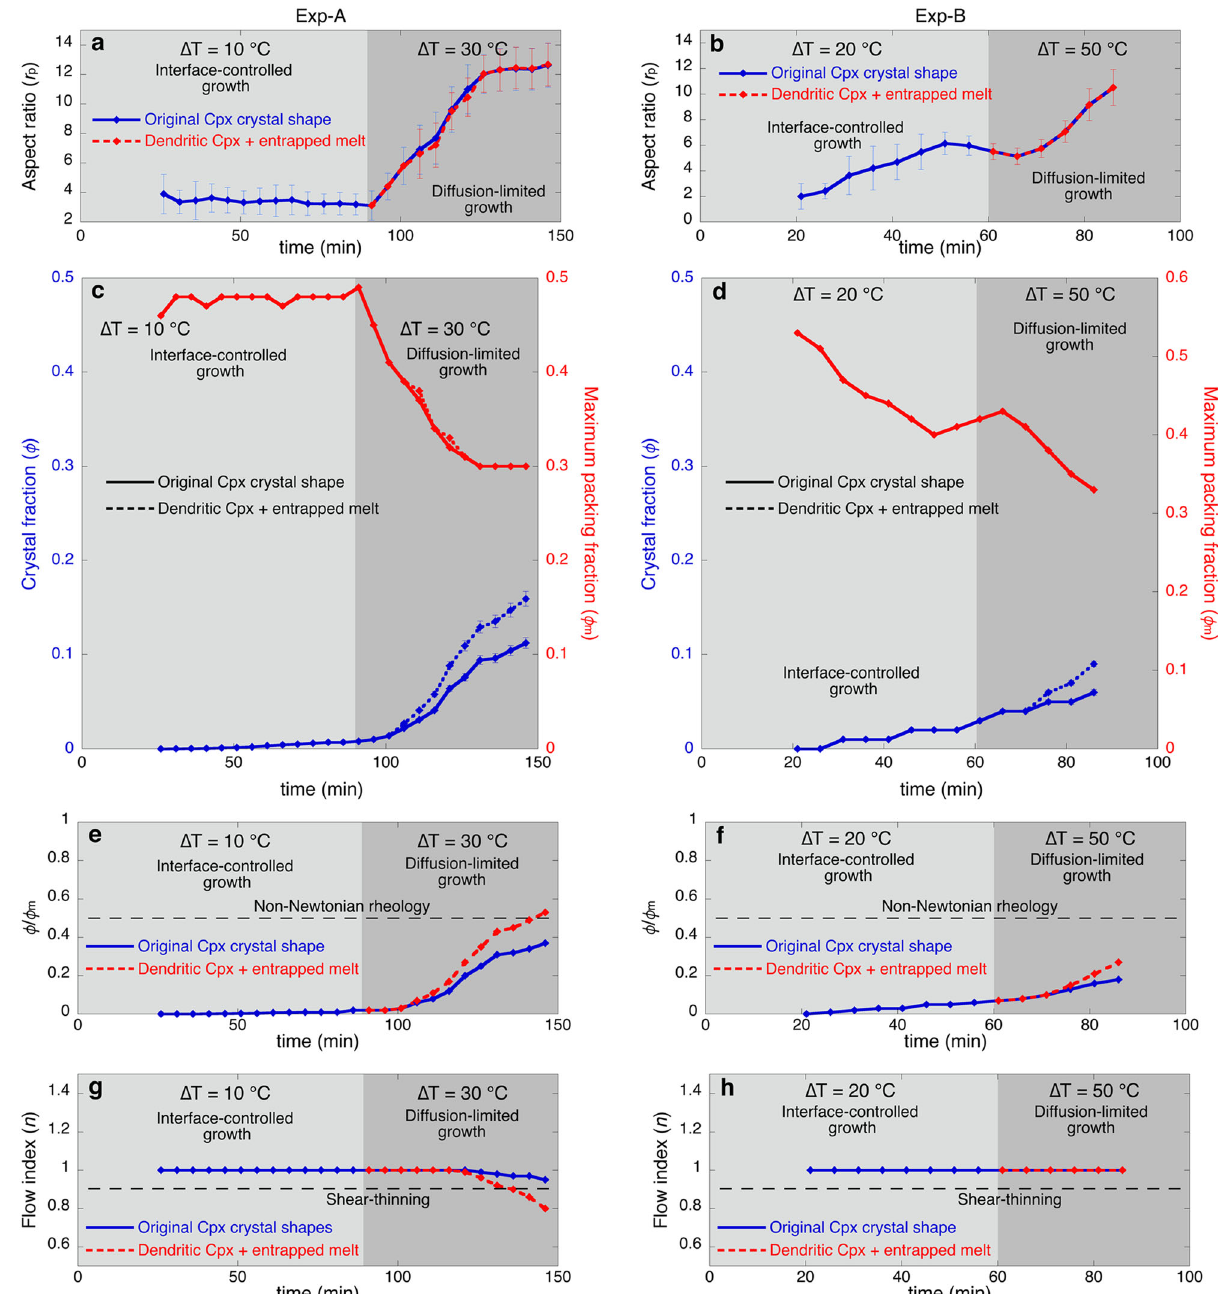
Fig. 5 Rheological transition of a trachybasaltic magma during crystallisation. a , b Evolution of clinopyroxene aspect ratio ( r p ) through time as a function of Δ T (undercooling) during the experiments Exp-A ( a ) and Exp-B ( b ). c , d Evolution of clinopyroxene crystal fraction ( ϕ ) through time as a function of Δ T during the experiments Exp-A ( c ) and Exp-B ( d ). Diffusion-limited growth, promoted at Δ T = 30 °C (Exp-A) and Δ T = 50 °C (Exp-B), favours dendritic crystal shapes which entrap melt within crystal branches. The entrapped melt within the original dendritic crystals (blue) is considered an additional solid part, which contributes to further increase the crystal volume of the dendritic crystals (red), increasing consequently the crystal volume fraction ( a , b ). c – h Evolution of the maximum packing fraction ( ϕ m ), ratio ϕ / ϕ m and fl ow index ( n ) which are indicators of the rheological behaviour of a crystal-bearing magma (Mader et al.). e , f Newtonian rheology is promoted at relatively low ϕ / ϕ m (<0.5), whereas non-Newtonian rheology, characterised for example by shear thinning, is more pronounced as ϕ / ϕ m increases. Shear thinning behaviour is promoted when n <1. a , c , e , g Light grey shading represents Δ T = 10 °C, dark grey shading represents Δ T = 30 °C. b , d , f , h Light grey shading represents Δ T = 20 °C, dark grey shading represents Δ T = 50 enhances the crystal fraction of magma. As a consequence, the packing fraction through formation of high aspect ratio crystals. effect of dendritic crystal growth has an enhanced impact on Progressive dendritic growth at high undercooling therefore magma rheology via two mechanisms: (1) by increasing the progressively decreases the fl ow index values (Fig. 5c – h and effective crystal fraction above that of the crystal phase alone, Supplementary Table 3), and we fi nd that the effect of entrapped through trapping of melt; and (2) by decreasing the maximum melt on the effective rheological properties of moving magmas